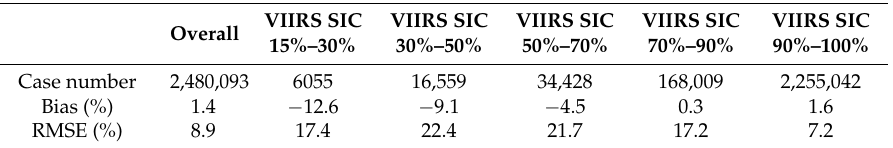
Figure 14. Comparison of VIIRS and Landsat ice concentrations for different concentration ranges/bins when a tie point adjustment scheme is employed. Table 8. Bias and RMSE with bias removed (precision) for comparisons of VIIRS minus Landsat ice concentrations for different concentration ranges/bins after tie point adjustment.